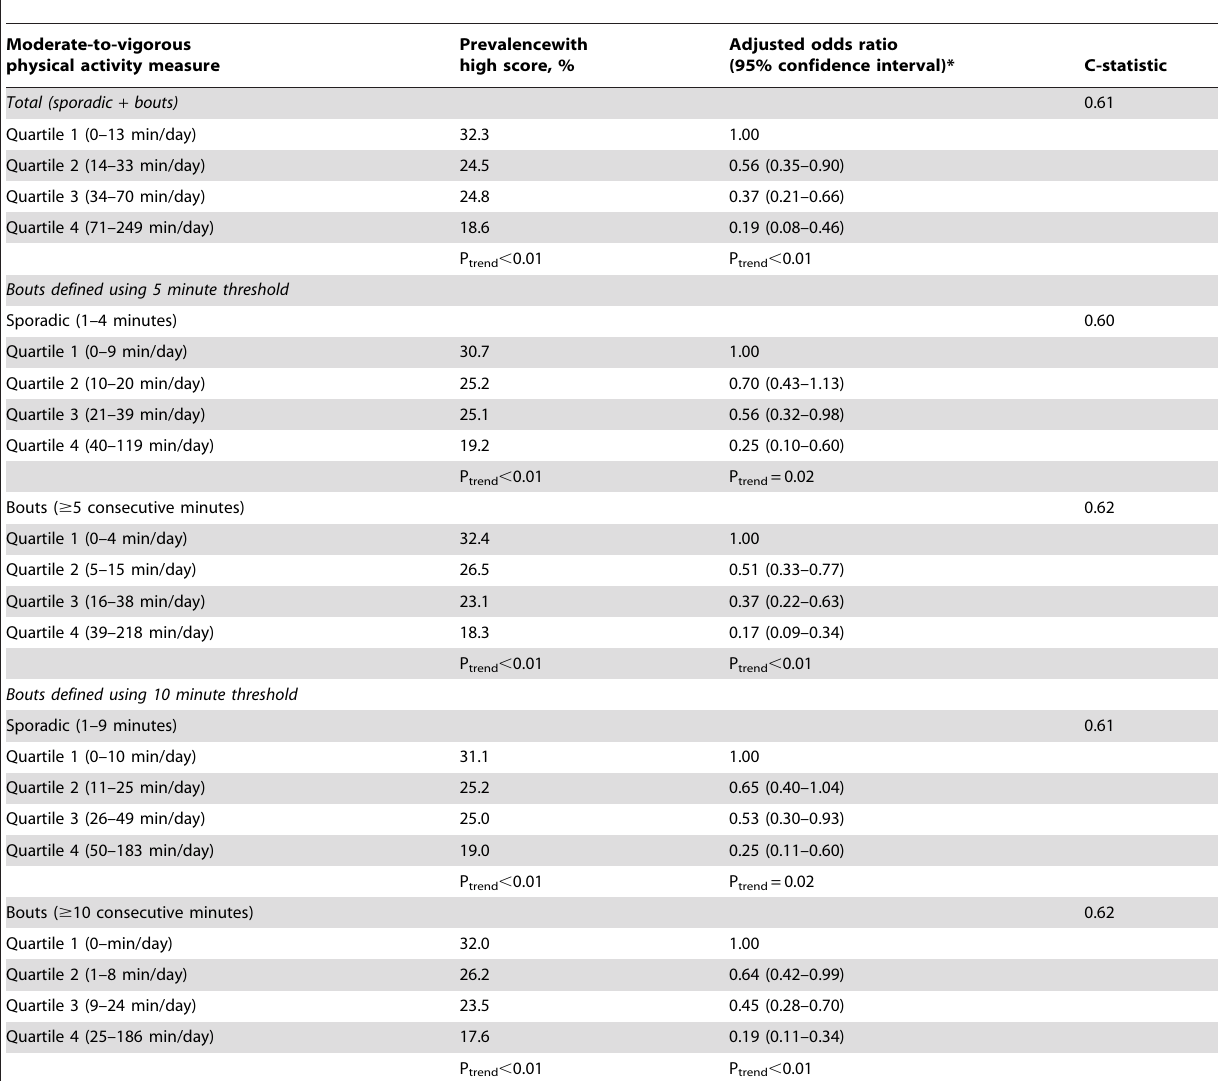
Table 3. Relations between moderate-to-vigorous physical activity measures and elevated levels of the summary cardiometabolic risk factor score